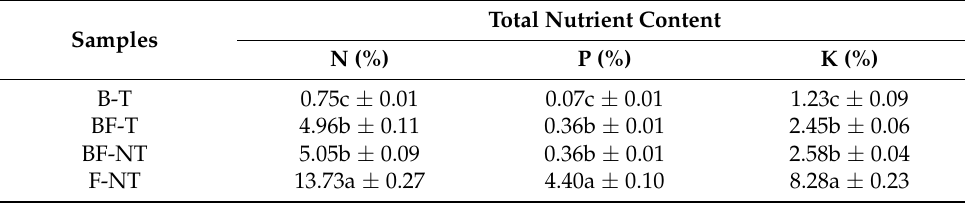
Table 1. Total N, P, and K contents of biochar tablets (B-T), biochar and fertilizer with (BF-T) and without tableting (BF-NT) in addition to NPK fertilizer